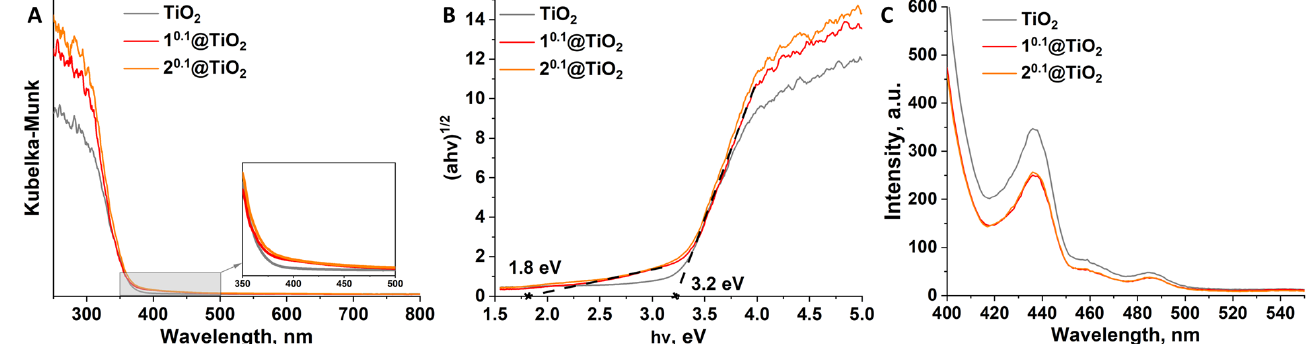
Figure 4. ( A ) Diffuse reflectance spectra of pure TiO 2 and n 0.1 @TiO 2 converted to absorption spectra using the Kubelka-Munk function; ( B ) Tauc plots used for determination of E g . Dashed lines are approximations of linear parts of the spectra. X marks interception with x axis and corresponds to E g values; ( C ) Emission spectra of powdered TiO 2 and n 0.1 @TiO 2 (λ ex = 320 nm).